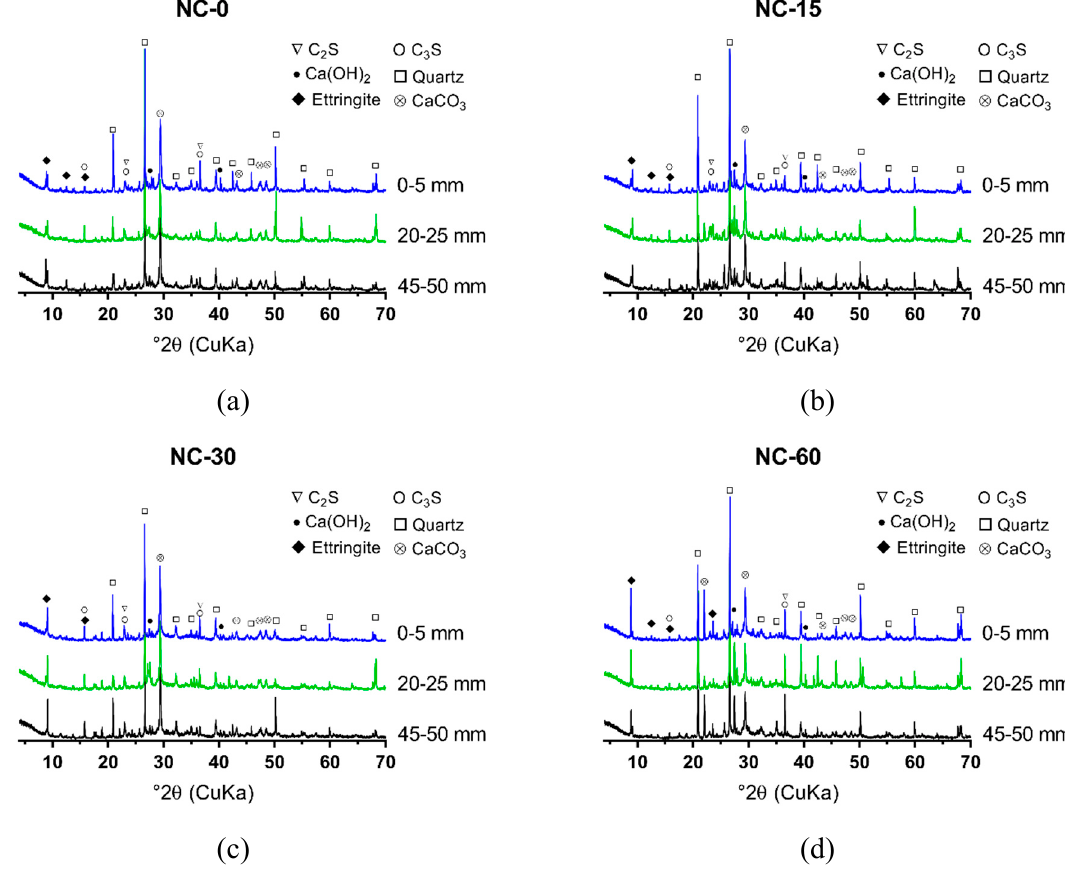
Figure 6. X-ray di ff raction (XRD) spectrum of the powder samples from ordinary concrete (NC), after 0, 15, 30, and 60 cycles of sulfate attack (sample location distance to the attack surface: 0–5 mm, 20–25 mm, and 45–50 mm): ( a ) NC-0; ( b ) NC-15; ( c ) NC-30; ( d )